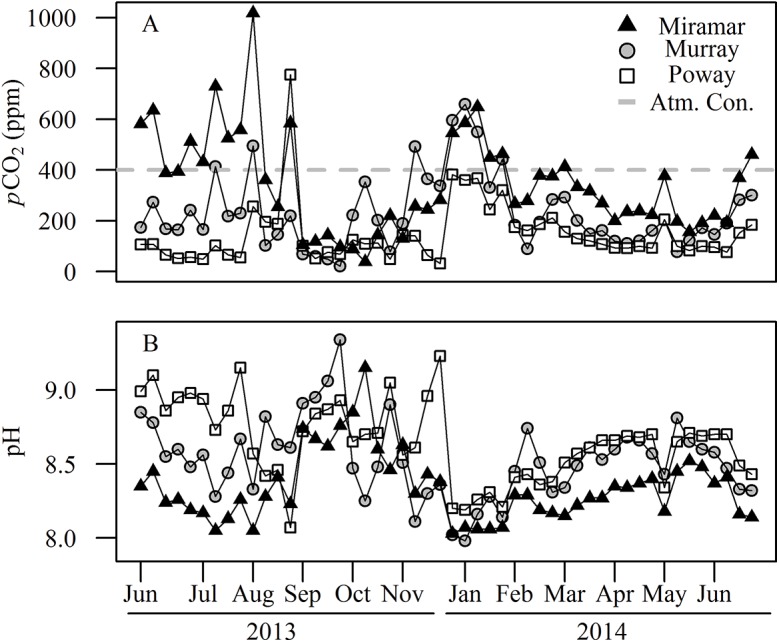
pCO2 and pH time series.(A) Time series of partial pressure of carbon dioxide (pCO2) in ppm for each of the three reservoirs. Current atmospheric concentrations of pCO2 are ~400ppm. (B) pH for each reservoir for 50 sampling weeks. Symbols indicate the reservoir as shown in the legend.